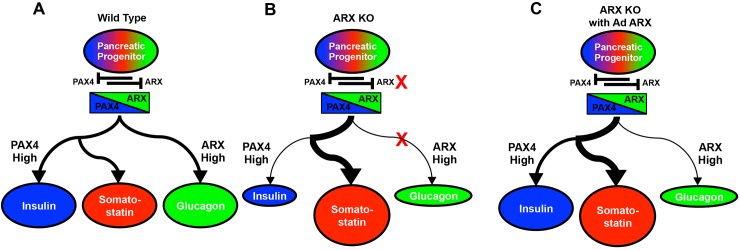
The Role of ARX in Pancreatic Endocrine Specificatin of hESCs.NGN3 induction in hESC derived pancreatic progenitors (PDX+ NKX6.1+) initiates the endocrine lineage. (A) In wild type hESCs, pancreatic endocrine progenitors express both PAX4 and ARX that are mutually corepressive. High expression of ARX specifies and maintains glucagon positive cells while elevated PAX4 levels drives the insulin and somatostatin lineages in normal abundance. (B) In the absence of functional ARX (ARX ko), repression of PAX4 is disrupted leading to a bias toward the insulin/somatostatin lineage. Elevated expression of HHEX as well as altered expression of other transcription factors, leads to large numbers of somatostatin cells at the expense of both insulin and glucagon lineages. (C) Re-expression of ARX in ARX ko pancreatic progenitors temporarily rescues ARX expression resulting in recovery of PAX6 expression (and other factors) which restores the specification of insulin positive cells. Glucagon positive cells are not rescued due to poorly sustained ARX expression in subsequent endocrine cells.